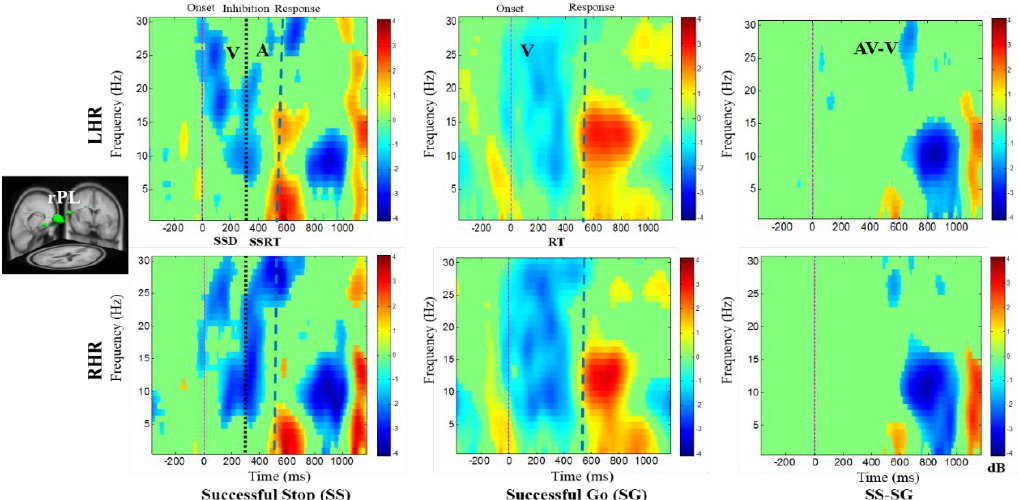
Figure 8. The ERSP plots showing the post-stimuli modulations in right parietal lobe (rPL) of the brain under combined visual (V) stimuli and auditory (A) alarms. Purple dashed line: Onset of the visual stimuli; black dashed line: Onset of the auditory alarms; blue dashed line: Onset of response. Color bars show the amplitude of the ERSP; statistical threshold at p < 0.01.